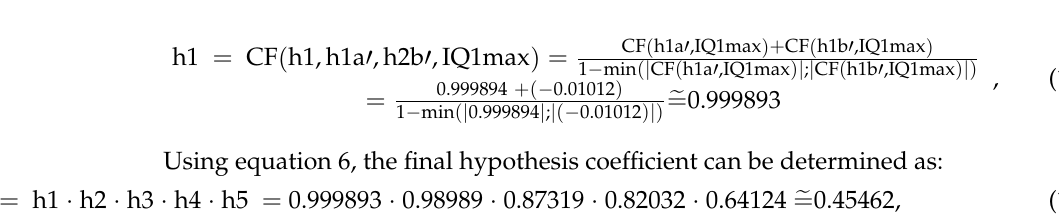
Figure 13. The result of the simulation of the h hypothesis value depending on the observation coefficients e1a.1 and e1b.1.